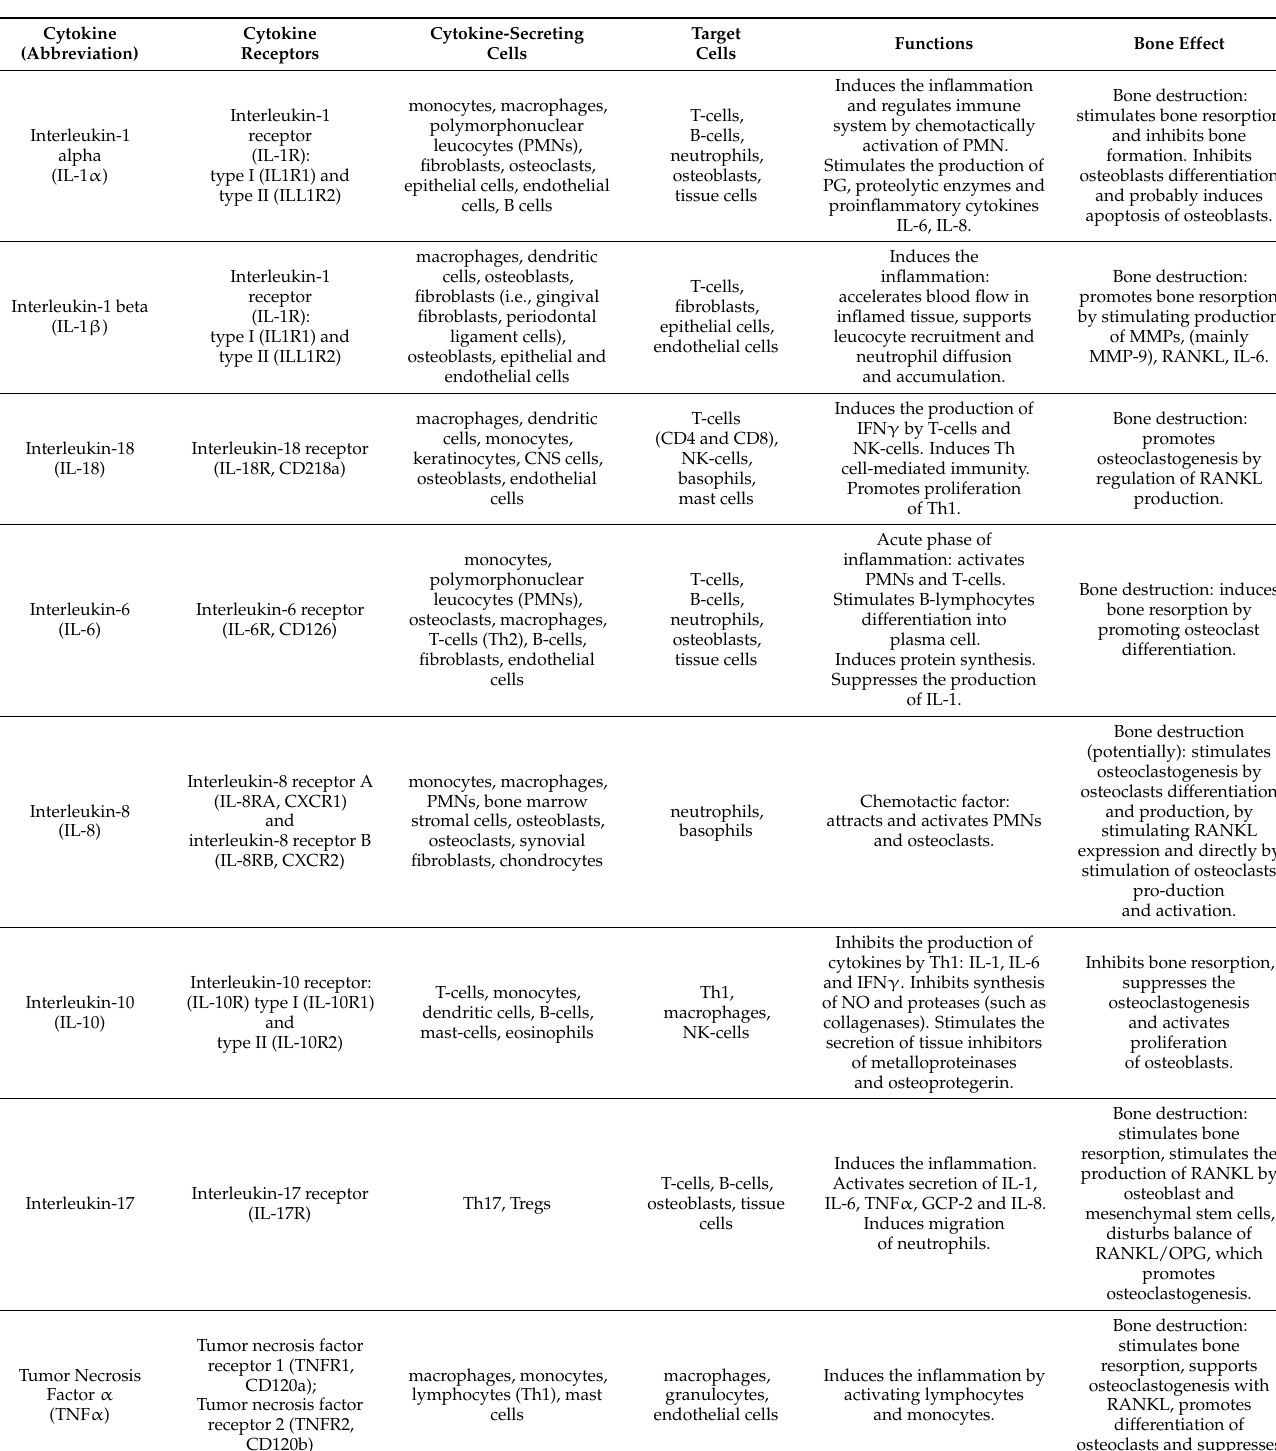
Table 1. General characteristics and functions of pro-inflammatory and anti-inflammatory cytokines which occur within the periapical lesions on the basis of the literature